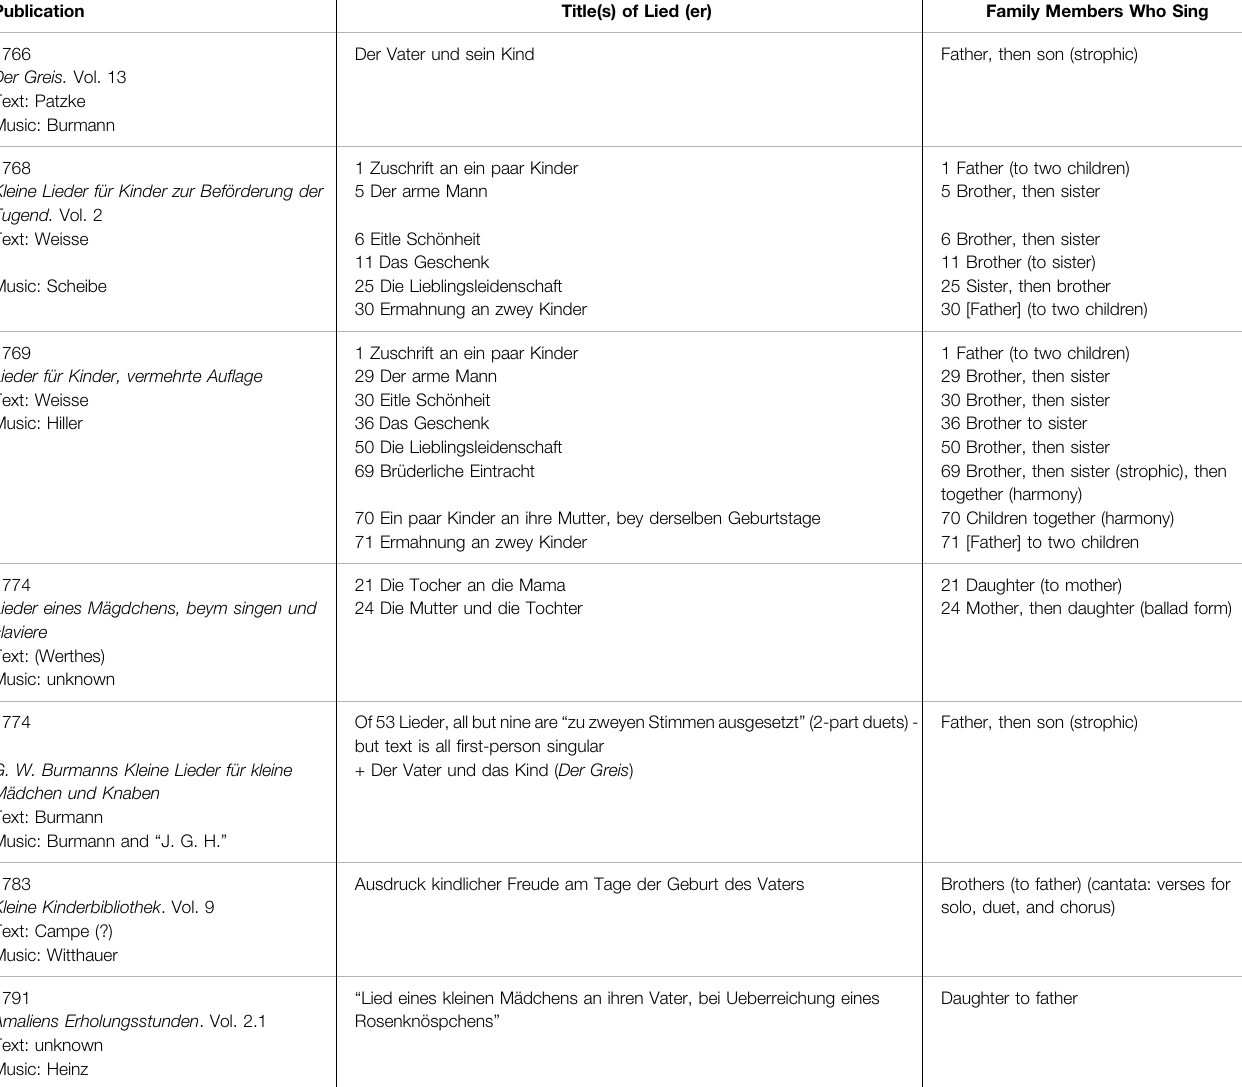
TABLE 1 | Lieder for Multiple Family Members in Selected Juvenile Periodicals and Kinderlieder Collections, 1760 – 1800.